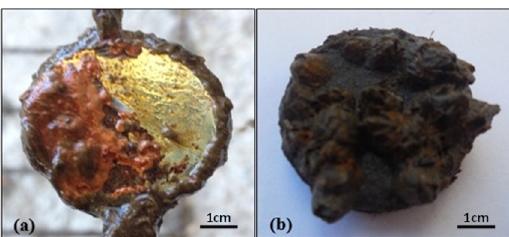
= 0.886) after 6 months of exposure 2 thin film; (b) face 2